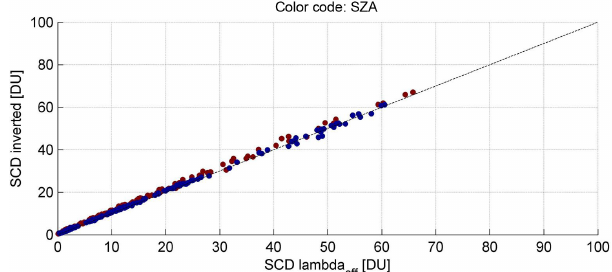
Figure 7. Retrieved SO 2 slant columns versus simulated SCDs at a wavelength of 313nm from synthetic spectra (SZA: 30, 70 ◦ ) in the spectral range 312–326nm and for SO 2 layers in the bound- ary layer, upper troposphere and lower stratosphere. The different points correspond to different values for the line-of-sight angle (0, 45 ◦ ), surface albedo (0.06, 0.8), surface height (0, 5km) and total ozone column (350, 500DU). SO 2 vertical columns as input of the RT simulations are a maximum of